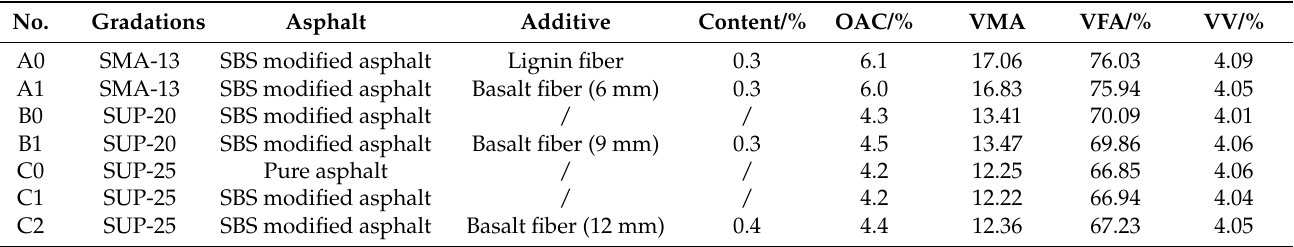
Figure 3. The gradation curves were conducted according to Technical Specification for Construction of Highway Asphalt Pavements (JTG F40-2004) [38]. Basalt aggregates and limestone aggregates were selected for SMA and SUP, the density of the aggregates is 2.927 and 2.698 g/m 3 , respectively. The details of the asphalt mixture samples were shown in Table 4, the properties of the mixture meet the requirements of JTG E20-2011 [37]. Table 4. Details of the asphalt mixture